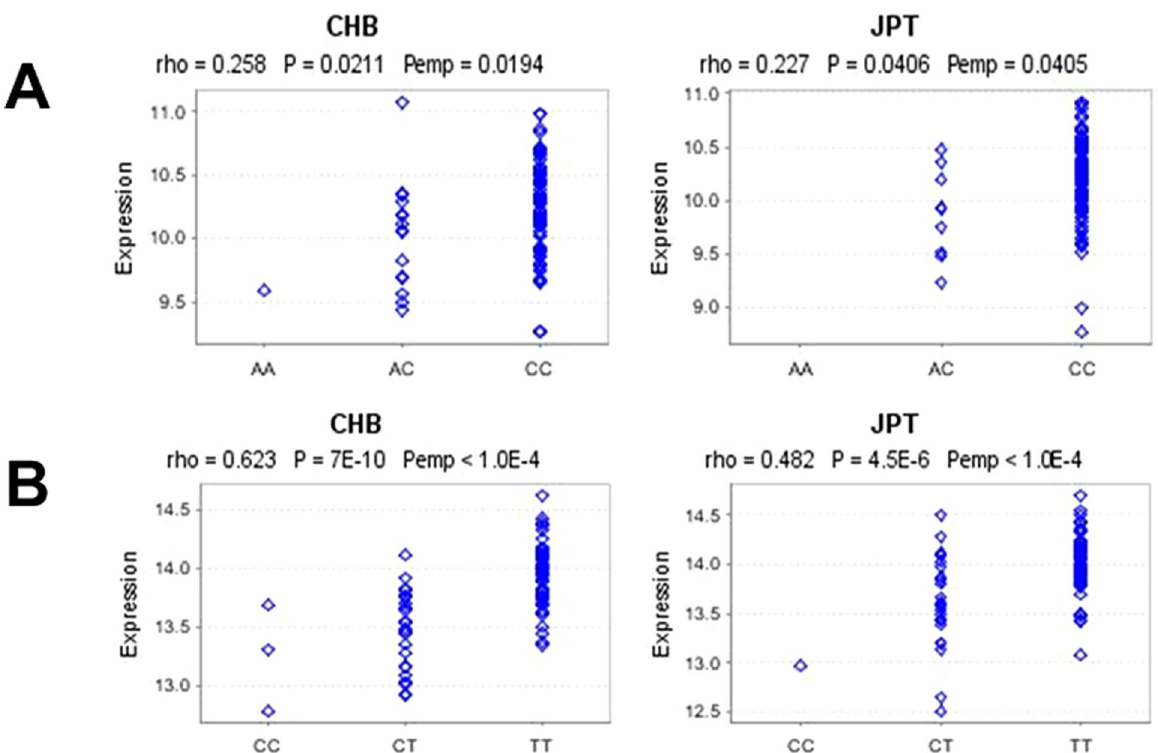
Figure 2. Cis-eQTL (cis-expression quantative trait loci) analysis of Fc receptor gene polymorphisms. ( Figure 2A ) associations between genotypes of FCGR2B rs12118043 and FCGR2B expression. ( Figure 2B ) associations between genotypes of FCRLB rs4657093 and FCRLA expression. eQTLs have been studied in lymphoblastoid cell lines (LCLs) from the HapMap3 Asian populations. The distance from the genomic location of the transcription start site (TSS) to SNP genomic location was less than 1 Mb. Spearman’s rank correlation coefficients (rho) and p values were presented. The data was derived from Genevar project (http://www.sanger.ac.uk/resources/software/genevar). CHB: 80 Han Chinese from Beijing, China; JPT: 82 Japanese in Tokyo, Japan.